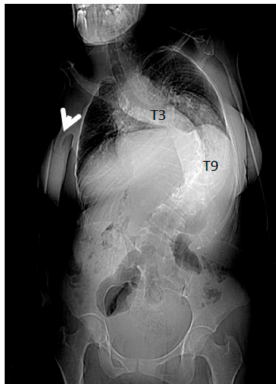
Figure 3. 3D reconstruction CT scan in a-20-years-old-girl showed severe flattening, fusion, shrinkage and compression of the dissolved thoracic spine T3-T9. Vanishing bone extended to involve the right shoulder joint resulted in total drop of the right upper limb (arrow). The combination of vertebral body osteolysis and unilateral right shoulder joint destruction resulted in the development of progressive kyphoscoliosis of 90 ◦ Cobbs angle. Note the dislocated right